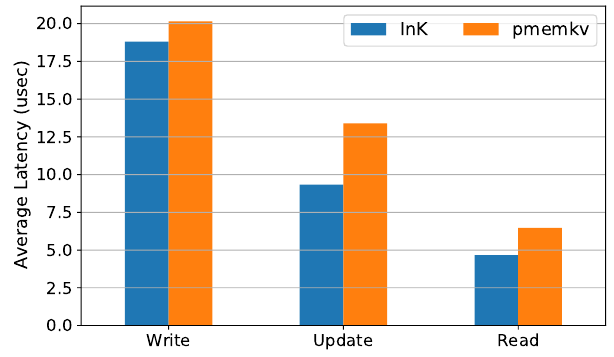
Figure 9. The basic performance of InK and pmemkv.